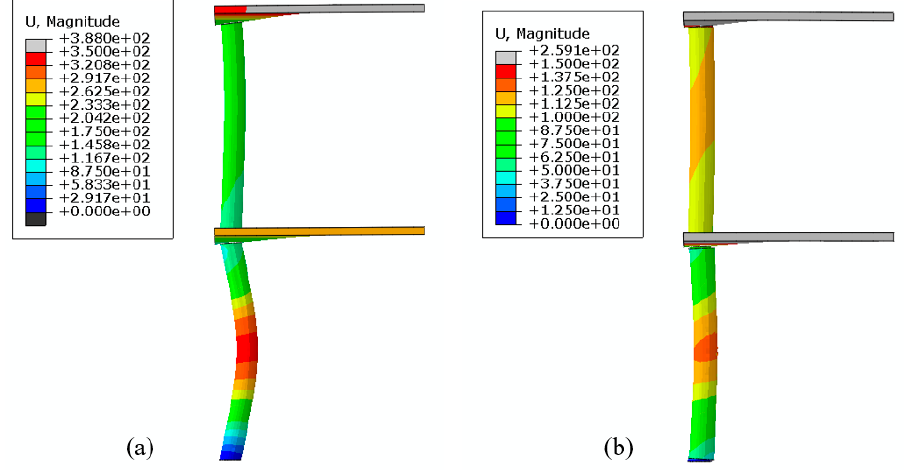
Figure 28. Comparison of the horizontal displacement fields at the maximum displacement ( a ) RC ( t = 29 ms) and ( b ) composite section ( t = 46 ms). The legends show the horizontal displacement in mm.